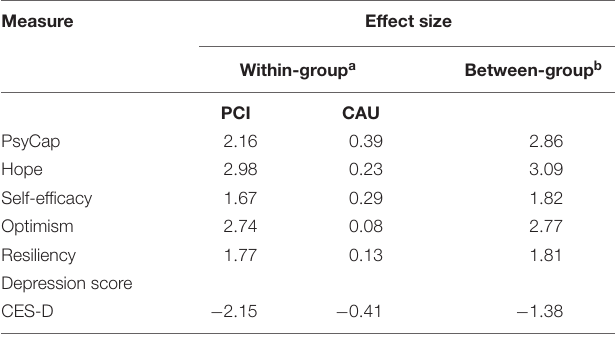
TABLE 2 | Effect sizes for pre- to post-test changes in the PCI and CAU groups.